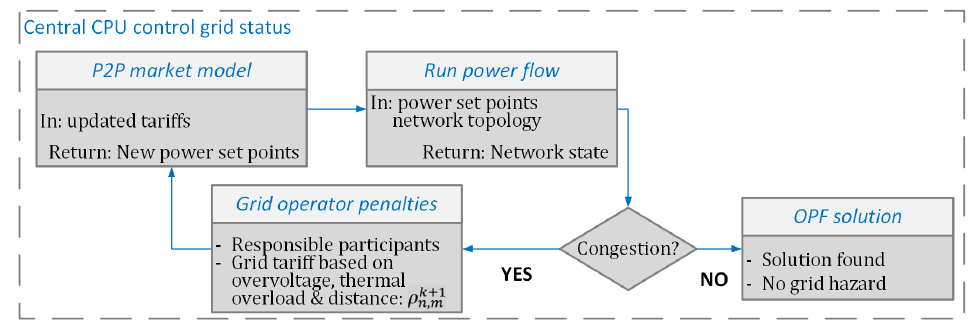
Figure 3. Diagram of central coordination control over secure network